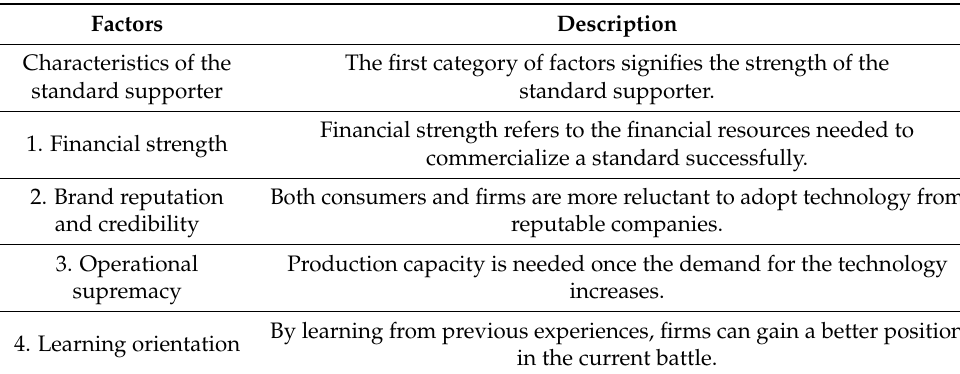
Table 2. Factors for standard success for committee–market standards battles for V2G technology (as adopted from Fulari